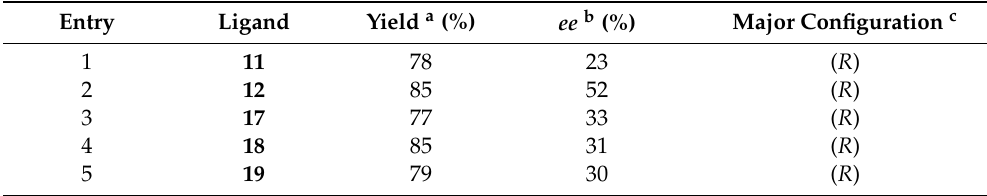
Table 2. Addition of diethylzinc to benzaldehyde, catalyzed by aminodiol derivatives.